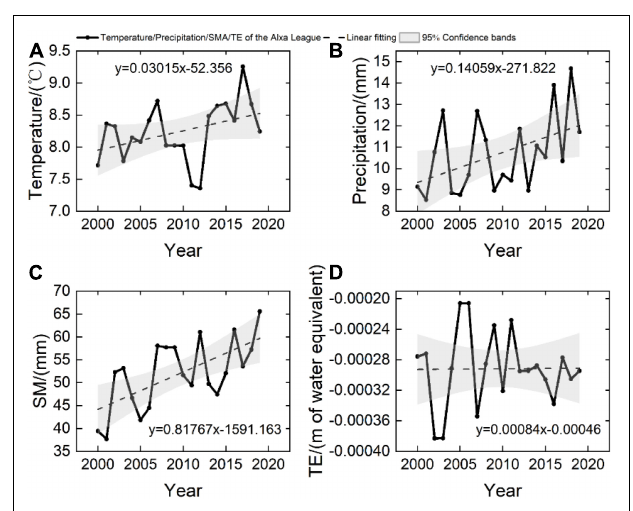
FIGURE 5 | Distribution characteristics of the average vegetation index in the range of different land use types, elevations, slopes, and aspects. Note: TC: tree cover, SL: shrubland, GL: grassland, CL: cropland, BU: built-up, BV: bare/sparse vegetation, PWB: permanent water bodies, HW: herbaceous wetland.